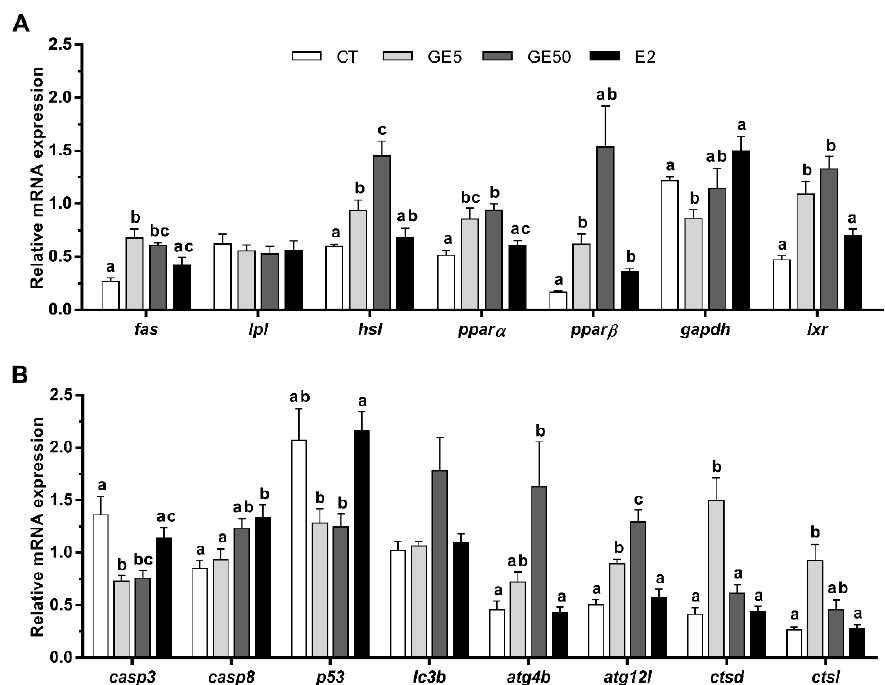
Figure 7. In vivo e ff ects on rainbow trout intraperitoneally injected with vehicle (DMSO diluted 1:3 in sesame oil) as CT, GE 5 µ g / g, GE 50 µ g / g, or E2 5 µ g / g over the expression of lipid metabolism, and apoptosis- and autophagy-related genes in white muscle. Relative mRNA expression normalized to ubq and ef1 α of ( A ) fas , lpl , hsl , ppar α , ppar β , gapdh , and lxr , and ( B ) casp3 , casp8 , p53 , lc3b , atg4b , atg12l , ctsd, and ctsl . Data are shown as mean + SEM ( n = 6–9). Significant di ff erences among treatments for each gene were determined by one-way ANOVA and are indicated by di ff erent letters ( p < 0.05). When two groups share at least one letter, they are not statistically di ff erent. CT: Control; GE: Genistein; E2: 17 β